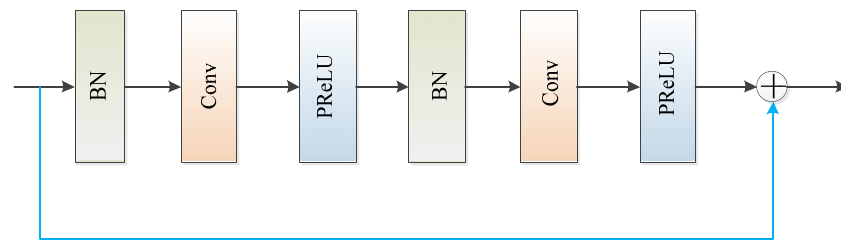
Figure 6. The structure of basic residual block.